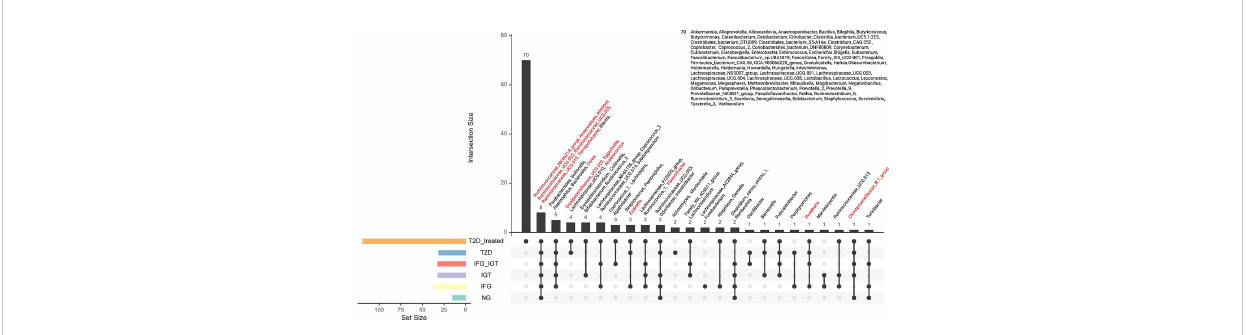
FIGURE 4 Core nodes for the Mexican T2D cohort. Each node represents a node in the SparCC association networks. The red color indicates “ driver nodes ” obtained from NetShift Analysis. Below, the black dots represent the presence of the core in the corresponding study group (e.g. T2D treated has 70 unique genera along with the cohort).